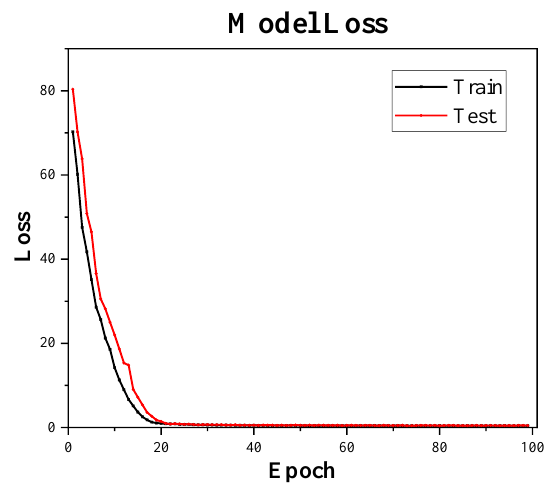
Figure 9. Training curves of the 1D-CNN network.